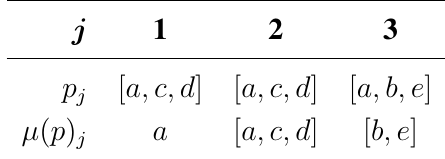
Table 3. Example of minimal representation of a pattern, m , with sequence, p